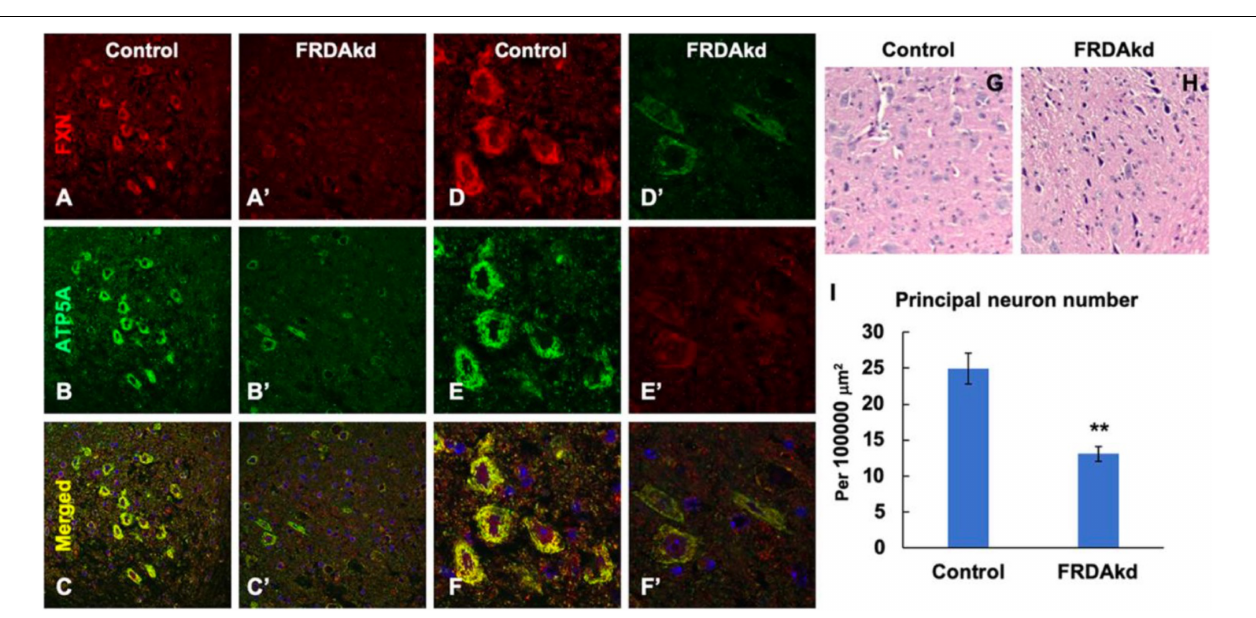
FIGURE 7 | The number of frataxin- and ATP5A-positive-cerebellar dentate nucleus principal neurons is decreased in FRDAkd mice at 18 weeks of dox treatment. Confocal images of frataxin (FXN) (red) and mitochondrial marker ATP5A (green) fluorescence, and merged images with DAPI-stained nuclei (blue) in the cerebellum of FRDAkd (A (cid:48) –F (cid:48) ) and control (A–F) mice. Hematoxylin-Eosin staining of cerebellar principal neurons FRDAkd (H) and control mice (G) . (I) Quantification of ATP5A-positive principal neurons in FRDAkd and control mice at 18 weeks of dox treatment (Stats: n = 3 mice per group, 3 sections per mouse, mean ± SEM, student’s t -test, ** P <